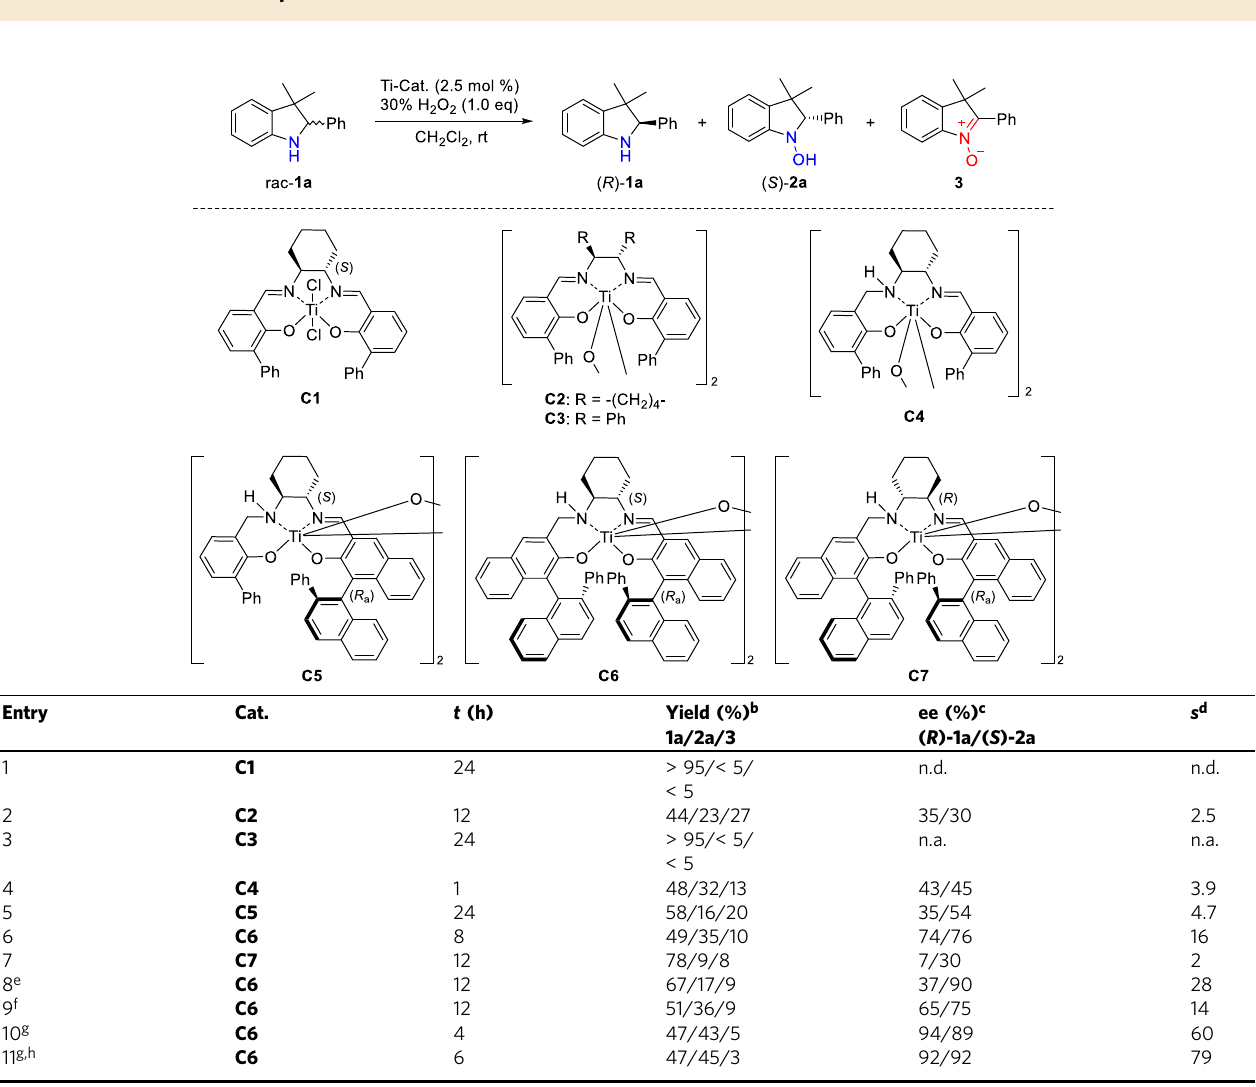
Table 1 Reaction condition optimization a